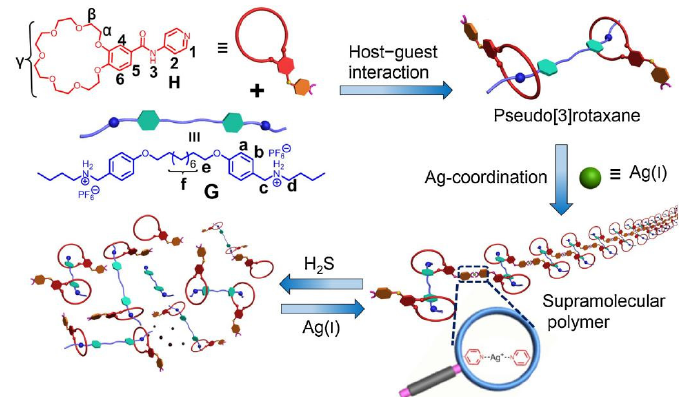
Figure 10. Schematic representation of assembly of supramolecular polymers and its response to H 2 S. Pseudo[3]rotaxane was firstly formed with benzo-21-crown-7 as the host molecule (H) and a homoditopic guest G via host–guest interaction. The further addition of Ag ions created supramolecular assemblies due to the coordination interaction between Ag and pyridyl group in H. The assemblies’ structural can be dynamically tuned by H 2 S. Reprinted with permission from Ref. [68]. Copyright 2019, Elsevier.